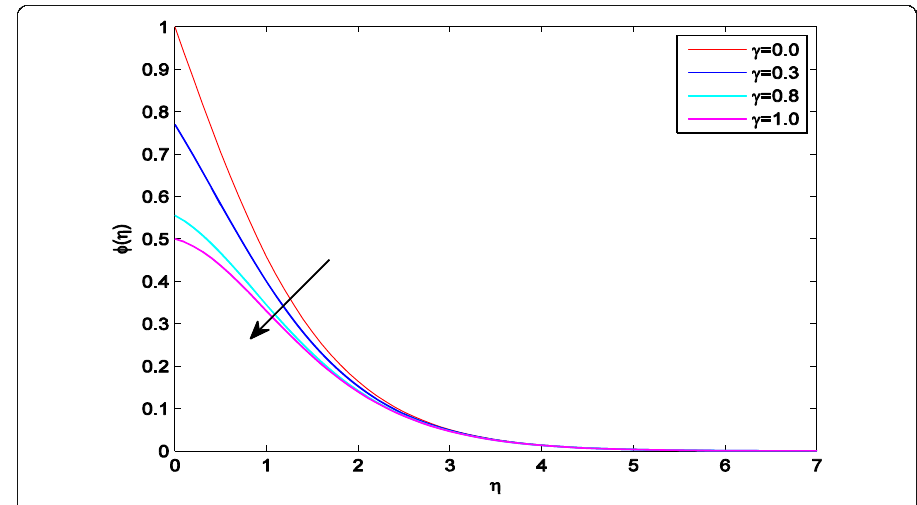
Fig. 26 Concentration graph for various values of